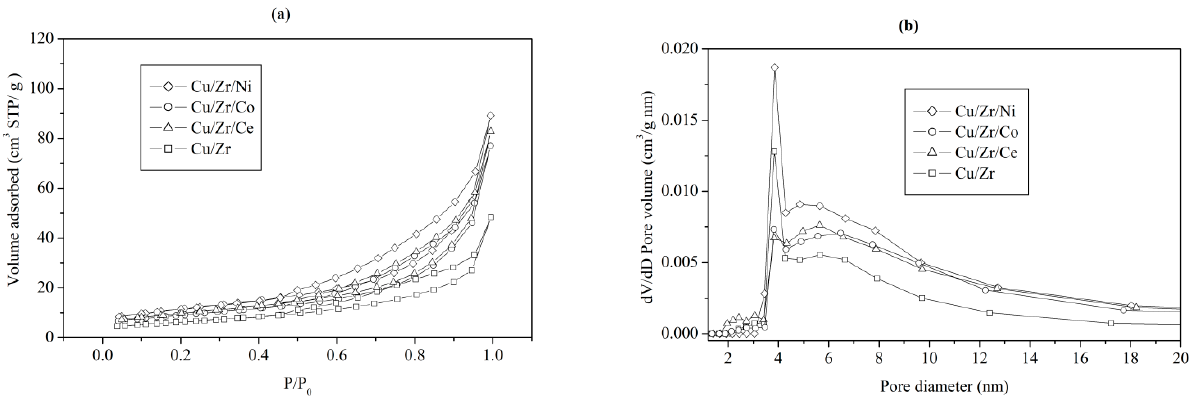
Figure 2. ( a ) N 2 adsorption/desorption isotherms (77 K) and ( b ) pore size distribution of the catalysts.